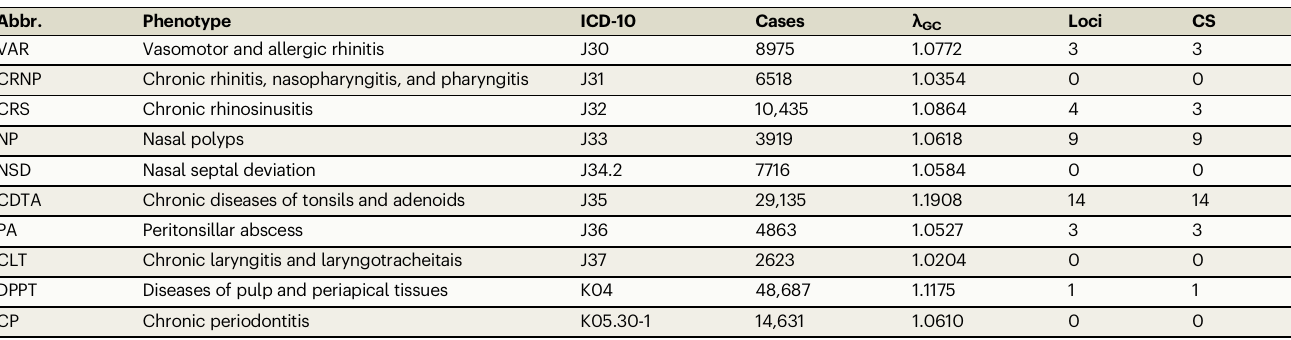
Table 1 | Description of genome-wide association studies